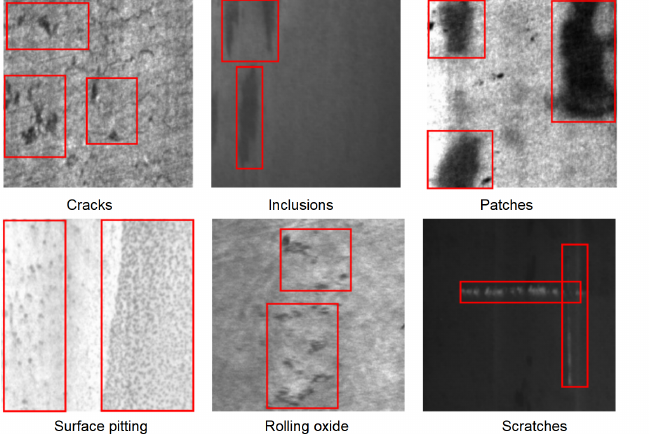
Figure 7. Visualization of steel dataset images, with red boxes representing defective